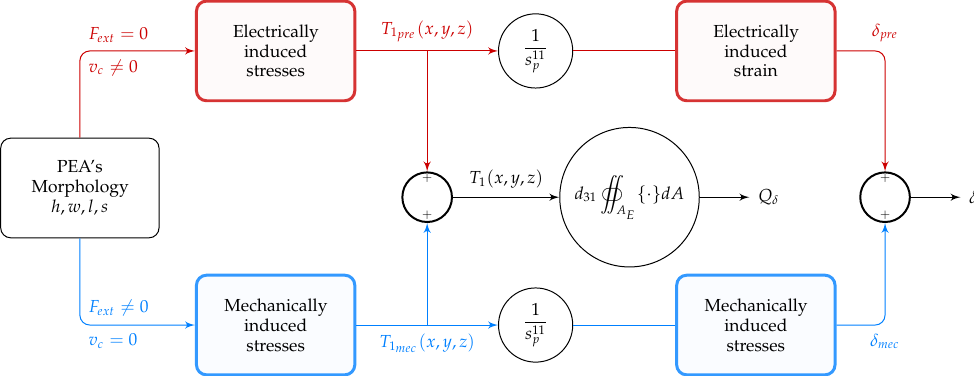
Figure 2. Schematic of the superposition of bending under external loading (—) and piezoelectric actuation (—). PEA, Piezoelectric